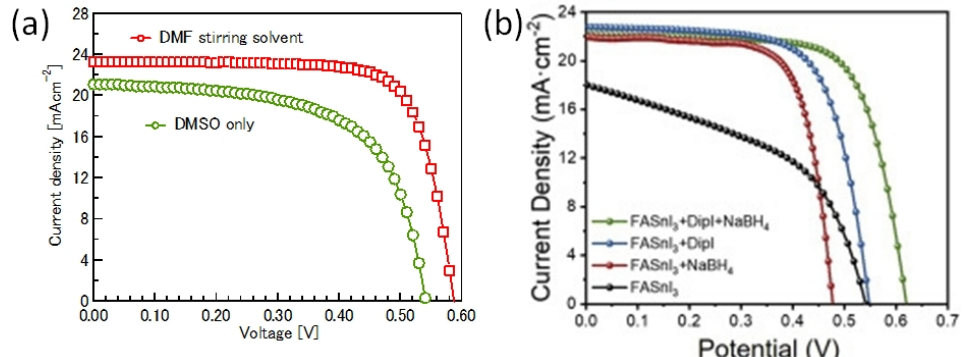
Figure 20. ( a ) Solvent stirring effect on photoelectric performance (24 h). Reprinted with permission [94]. Copyright 2022, American Chemical Society. ( b ) Average representative J − V curves with and without additive after 3 days of light soaking. Reprinted with permission [115]. Copyright 2022, Elsevier Inc.